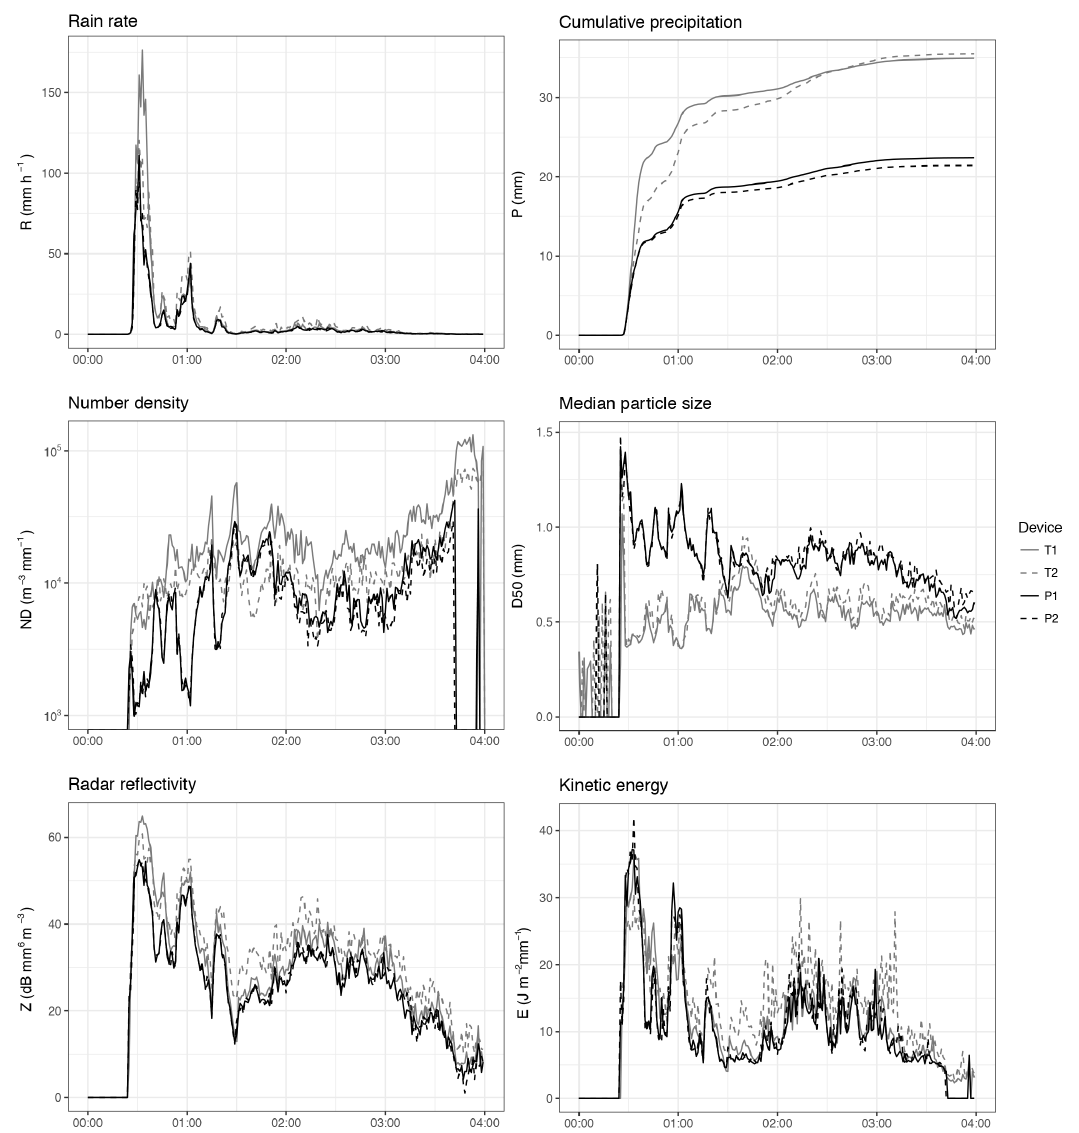
Figure 3. Time series of disdrometer bulk variables during a high-intensity event (E365, 25 November 2014).